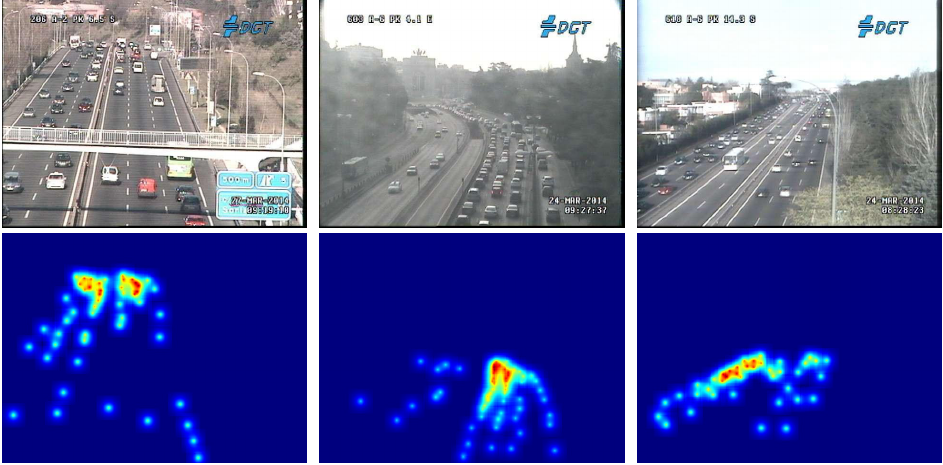
Figure 1. Examples of dense traffic images from TRANCOS [10] dataset and its corresponding density